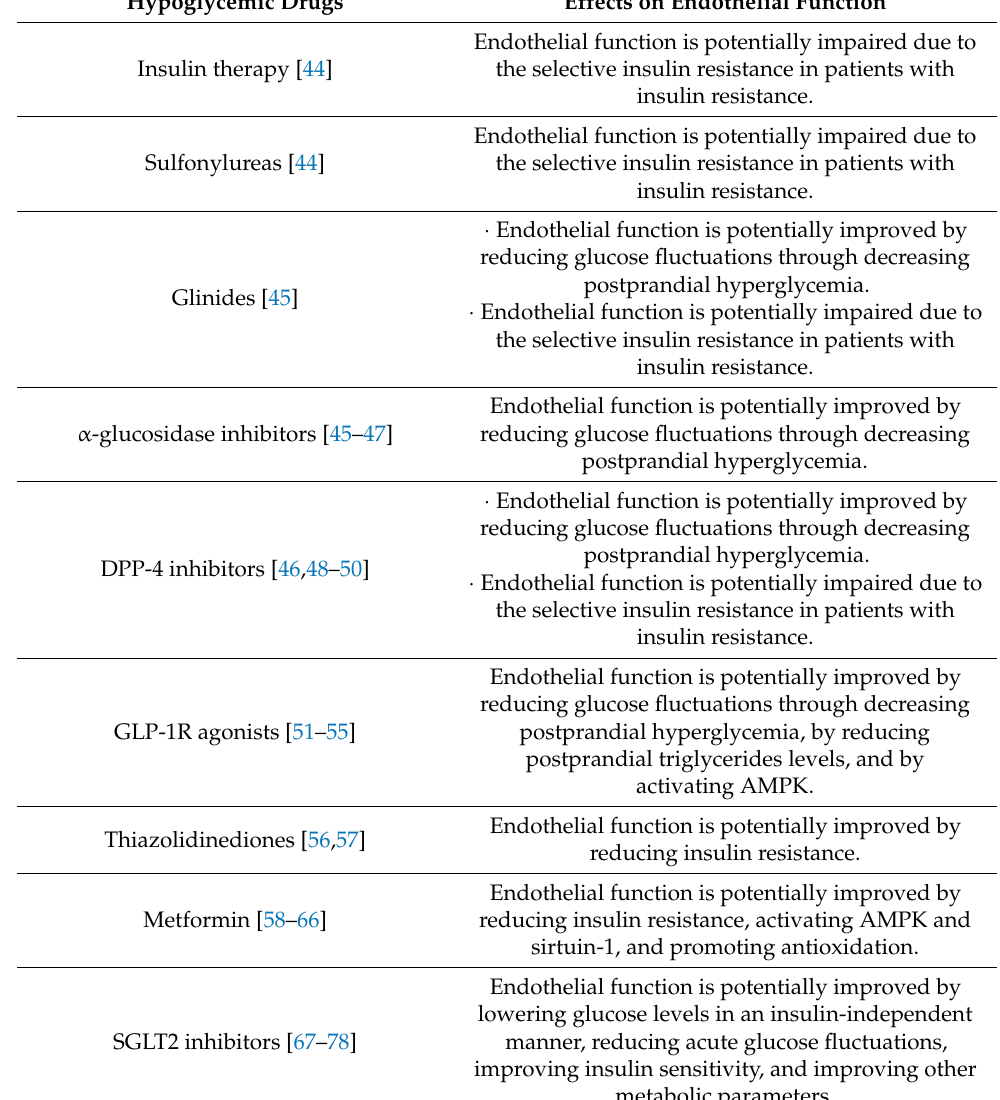
Table 1. Hypoglycemic drugs and their effects on endothelial